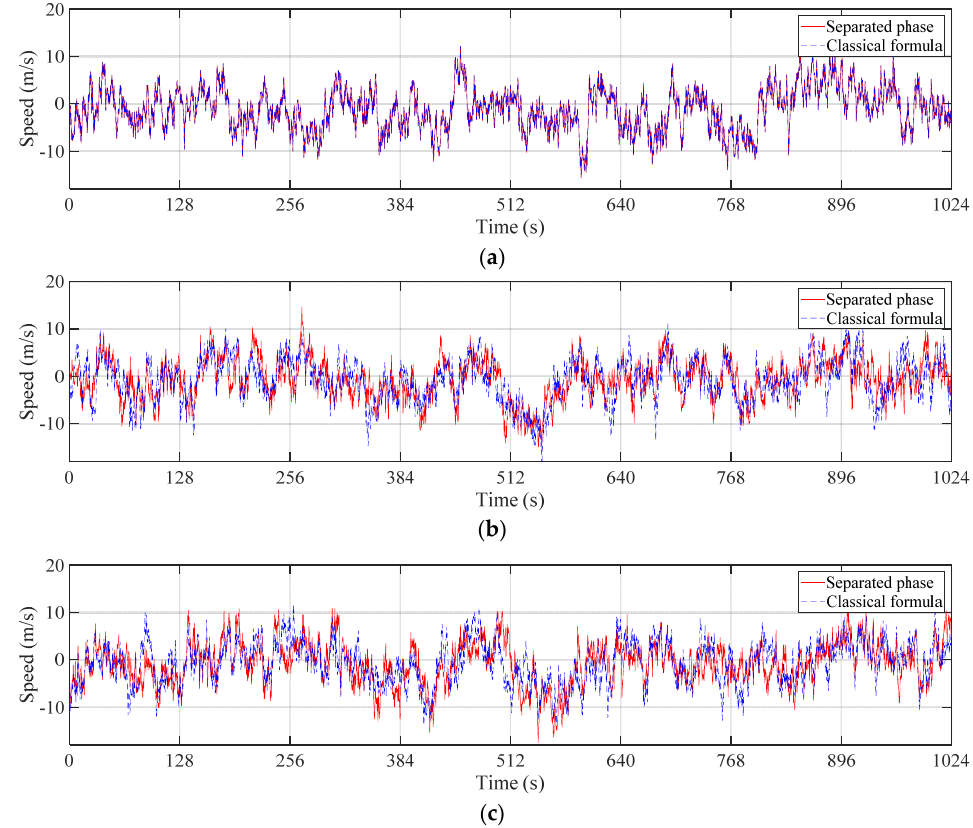
Figure 5. Simulated ergodic stationary wind fluctuation samples (first 1024 s): ( a ) Point 1; ( b ) Point 21; ( c ) Point 41.